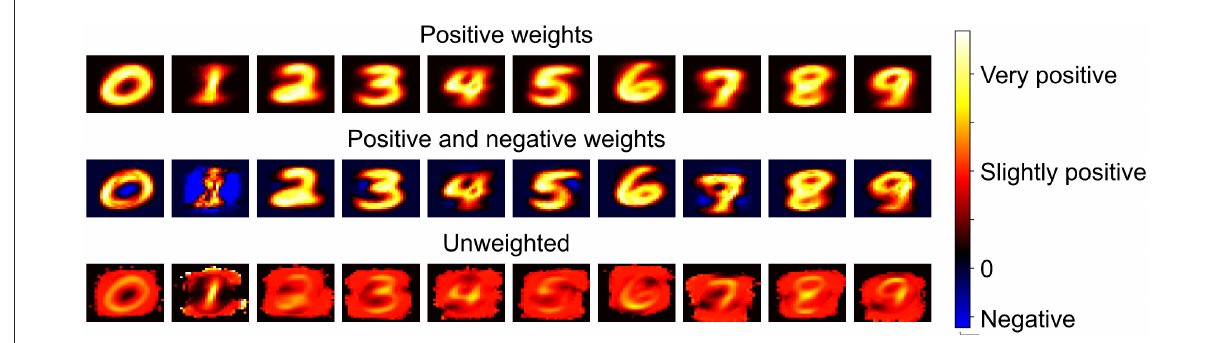
FIGURE9 The values of v stored on each neuron’s incoming synapses form a record of the inputs which were captured by EDN during training. The weight on the synapse connecting the neurons to the outputs enables the receptive field of each class to be determined by multiplying the stored values by their neuron’s associated weights. When taking the positively weighted neurons of each class and multiplying their stored v values by their associated output weight you create the first row of the plot, this forms an weighted expectation of each class. The second row is generated by also including the negatively weighted neurons connected to each output, showing the average receptive field of each class. The bottom row is an unweighted combination of the input synapses which are instances of each